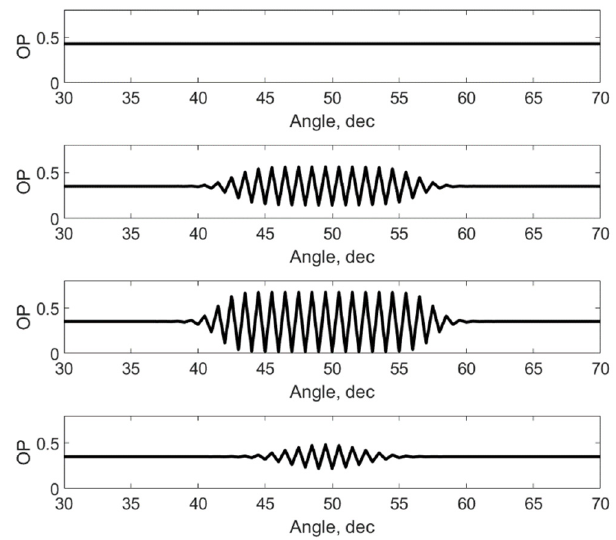
Figure 4. Dynamics of the order parameter distribution depending on the radius in the vicinity of the defect.